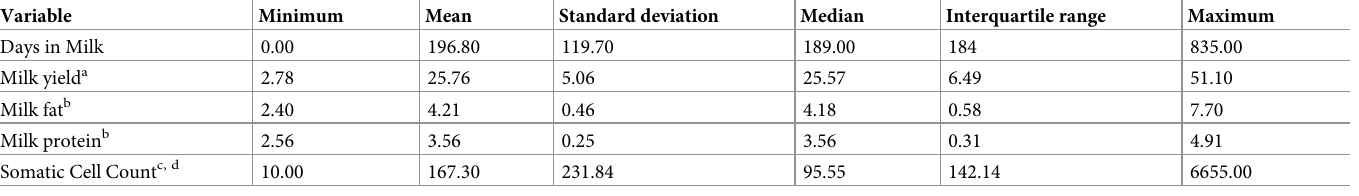
Table 2. Animal level descriptive statistics of continuous variables within the final, complete cases data set for analysis (7,320 cows on 166